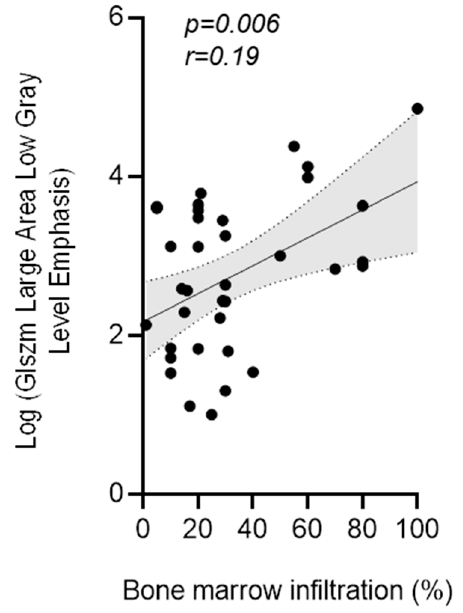
Figure 6. Correlation between the course of GLSZM large area low gray level emphasis and M-protein with the degree of bone marrow infiltration GLSZM large area low gray level emphasis in T1w sequences measured in the wing of ilium showed significant ( p = 0.006; r = 0.19) correlation with the degree (%) of bone marrow infiltration by myeloma cells confirmed by bone marrow